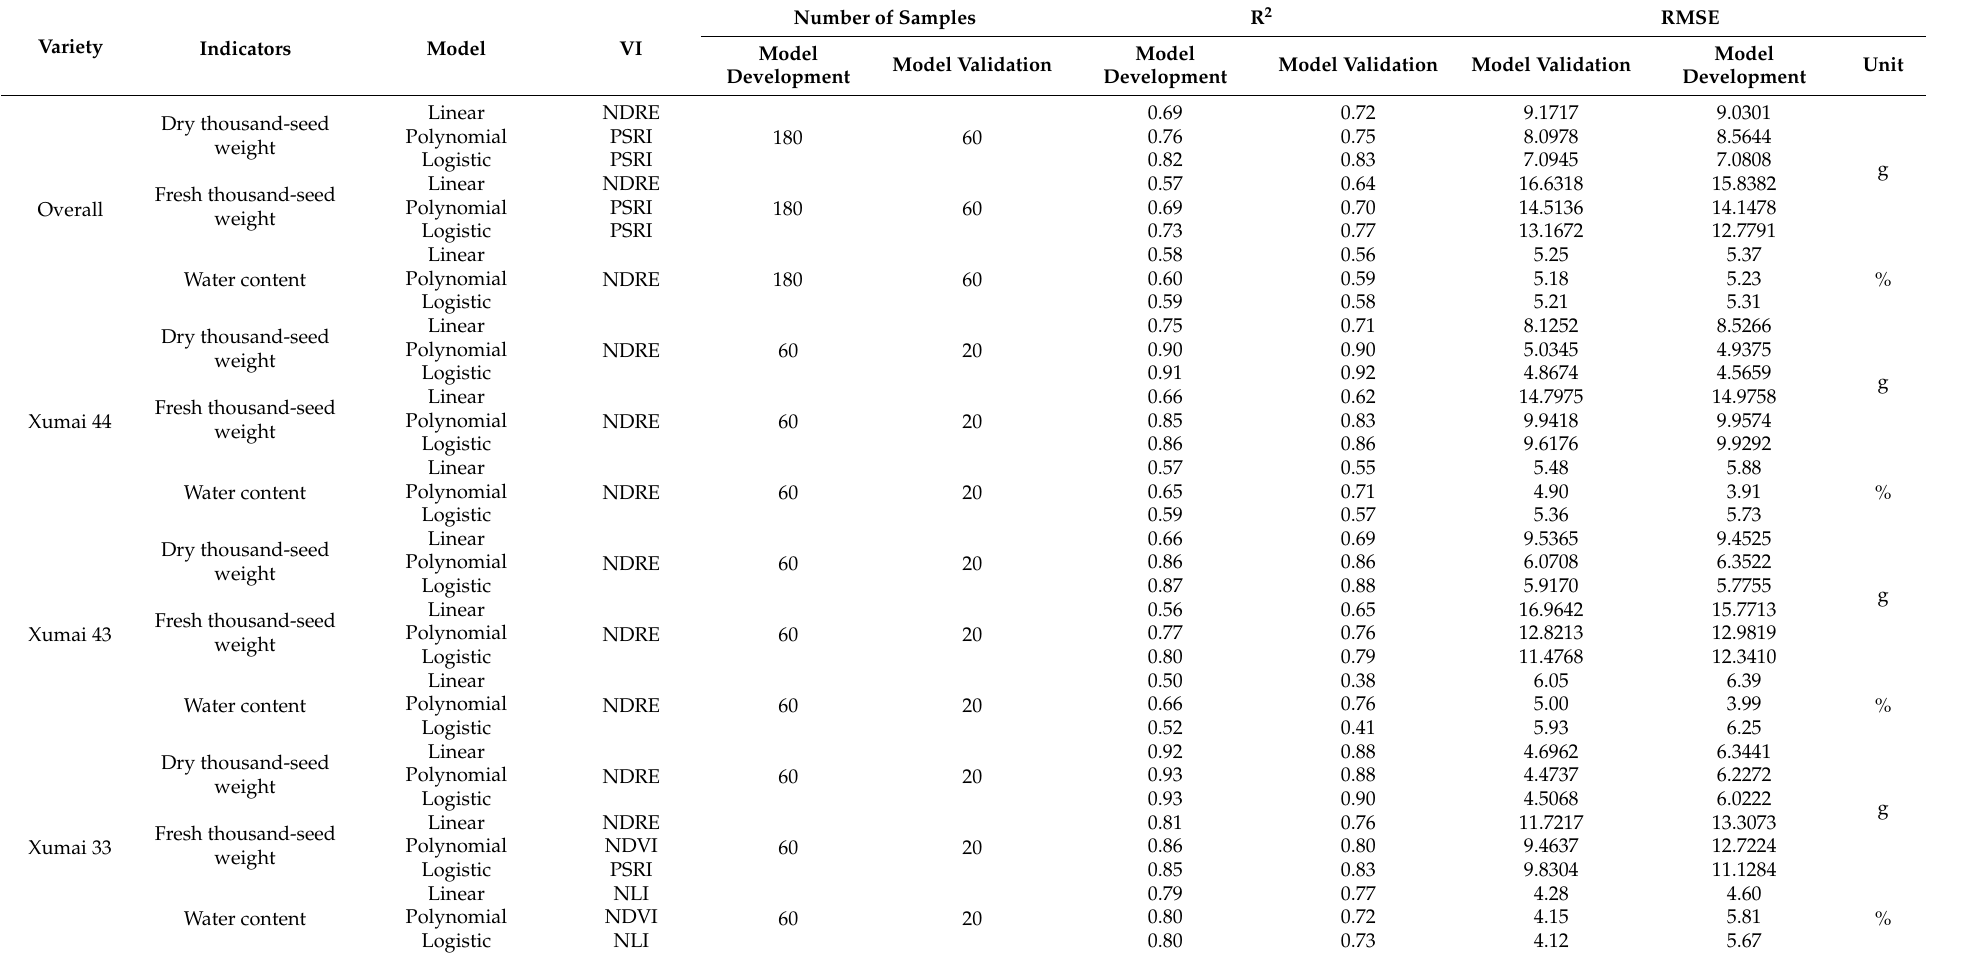
Table 3. Comparison of monitoring models for the grain-filling process of winter wheat under different indicators and